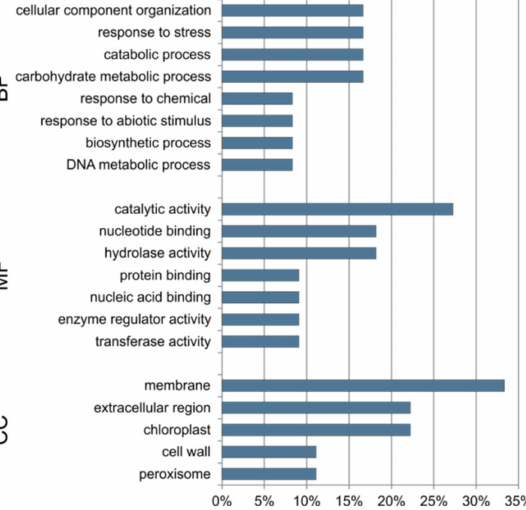
Figure 10. Percentage of GO terms assigned to 10 target genes that are common to all three cucumber somaclonal lines (S1, S2 and S3). BP—biological process, MF—molecular function, CC—cellular